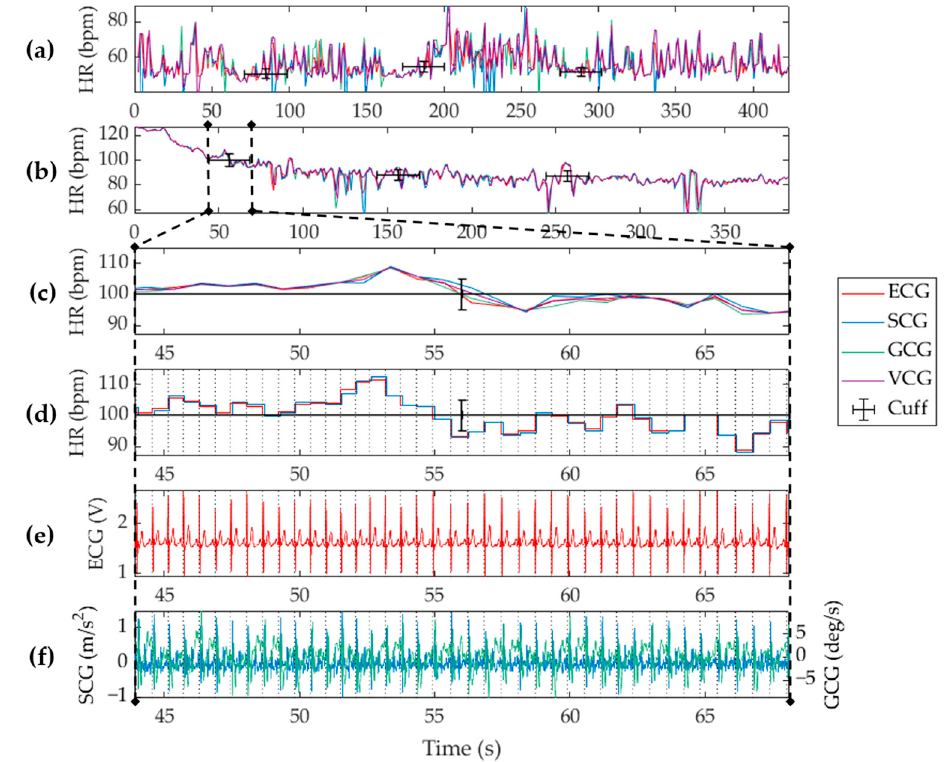
Figure 5. Biometric measurements from a single subject using the proposed cardiac electro-mechanical monitoring system when the subject was lying supine ( a ) at rest, and ( b ) recovering from physical exertion. Heart rate measurements obtained from ECG (red), SCG (blue), GCG (green), and VCG (purple), are shown with the cuff measurements (black) overlaid. A zoomed snippet of the dataset is shown for ( c ) the ADA-based heart rate, and ( d ) beat-to-beat (BTB)-based heart rate. Shown also are ( e ) the raw vibrational signals, and ( f ) the ECG signal. Vertical grey dotted lines show detected beats.